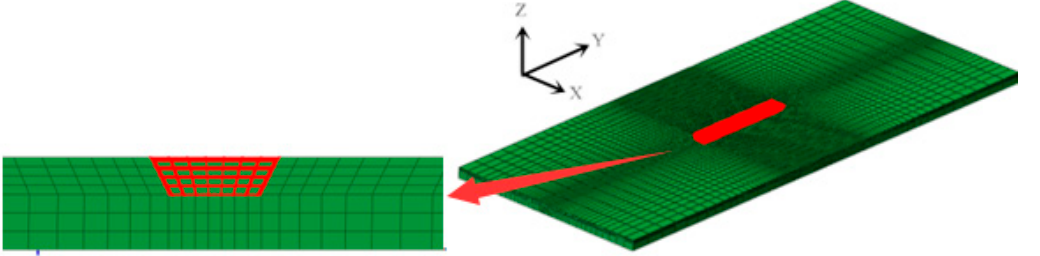
Figure 4. Finite element meshing of repaired specimen.